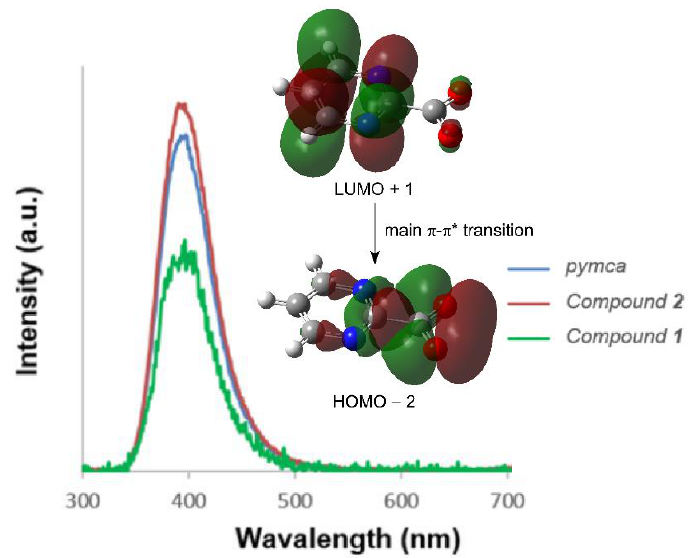
Figure 7. Emission spectra of compound 1 (green line), compound 2 (red line), and pymca ligand (blue line) at λ ex = 240 nm. Inset shows the main electronic transition occurring in the ligand.